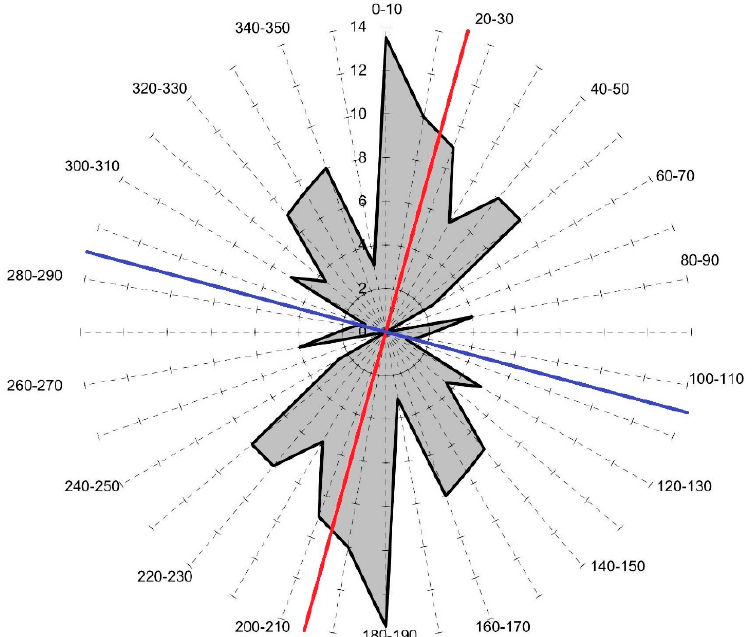
Figure 8. Rose diagram of the lineaments in the Ouagadougou sector. The directions shown in red (N 15) and blue (N 105) correspond to those obtained when maximising and minimising differences of the directional variograms, respectively (modified from Ouandaogo-Yaméogo (2008) [24]). The density of the measurements also reveals a series of hot spots within the